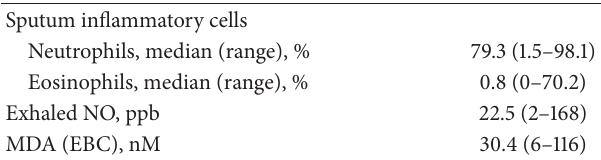
Table 2: Biomarkers measured in the sputum, EBC, and exhaled air in the examined patients with